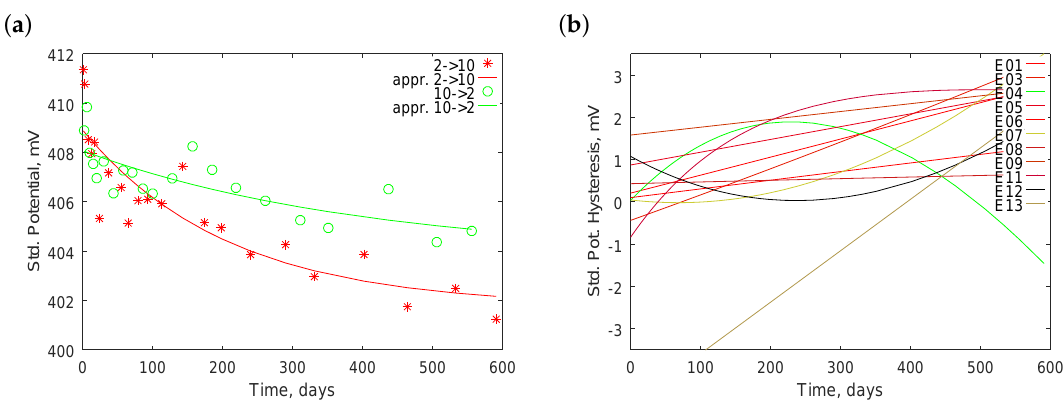
Figure 11. Illustration of dependence of hysteresis effect on electrode standard potential: ( a ) example of E11; and ( b ) hysteresis of all electrodes tested.